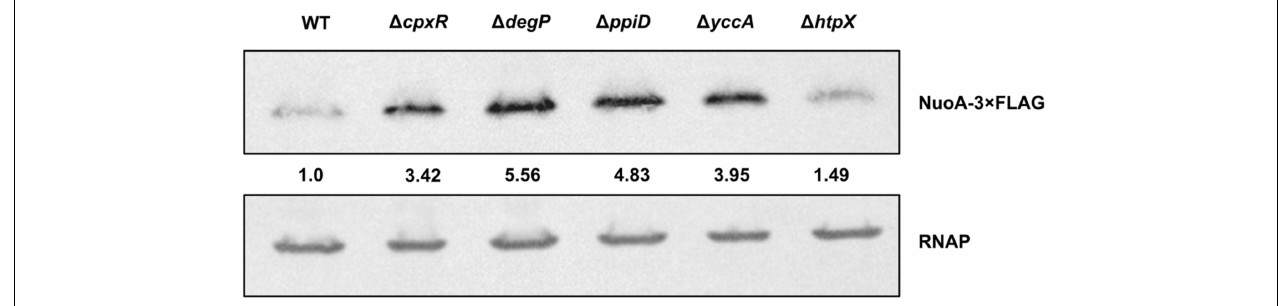
FIGURE 6 | NuoA-3 × FLAG protein levels are altered by deletion of several Cpx-regulated protein folding and degrading factors. Western blot utilizing anti-FLAG tag antibody was performed on wildtype BW25113 E . coli and the mutants with the indicated gene deletions containing the pMPM- nuoA -3 × FLAG expression vector. RNAP protein levels served as a loading control. Membranes were imaged using the Bio-Rad ChemiDoc MP imaging system. Relative band quantification was performed using band intensity analysis in ImageJ. Band intensity is represented by the value relative to the wildtype NuoA-3 × FLAG protein